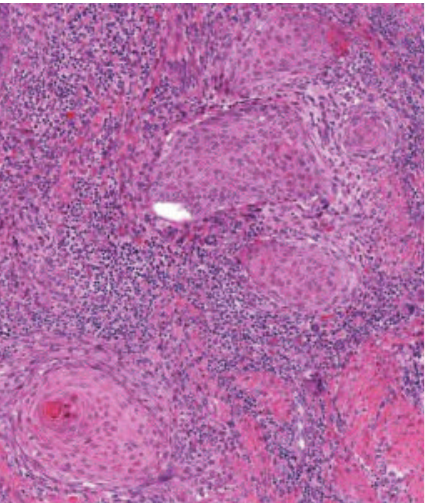
Figure 4: Area extracted from the whole slide image showing nests of invasion and surrounding inflammation (HE).